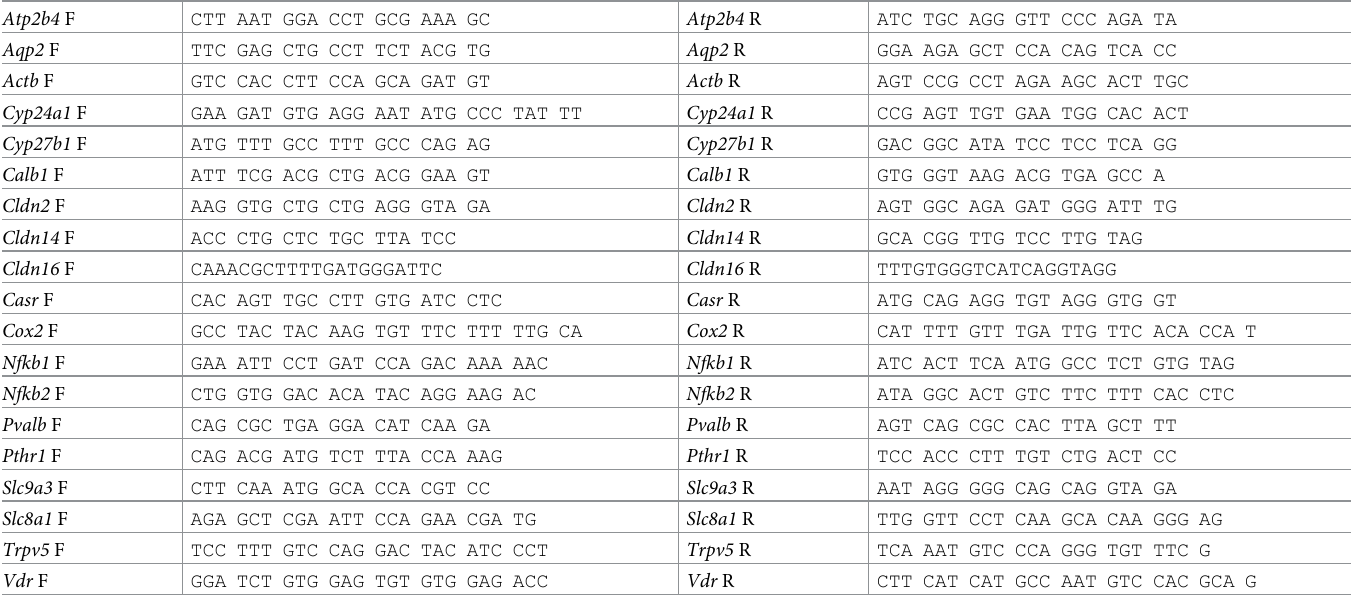
Table 1. Primers